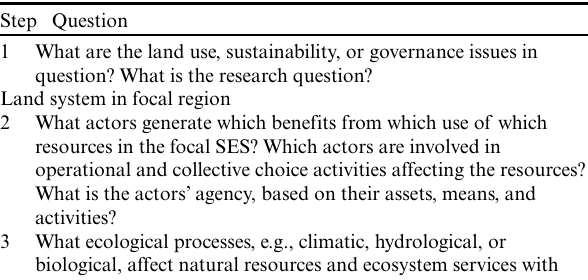
Table 1 . Diagnostic procedure to operationalize telecoupled systems and polycentric governance for integrated analysis using networks of action